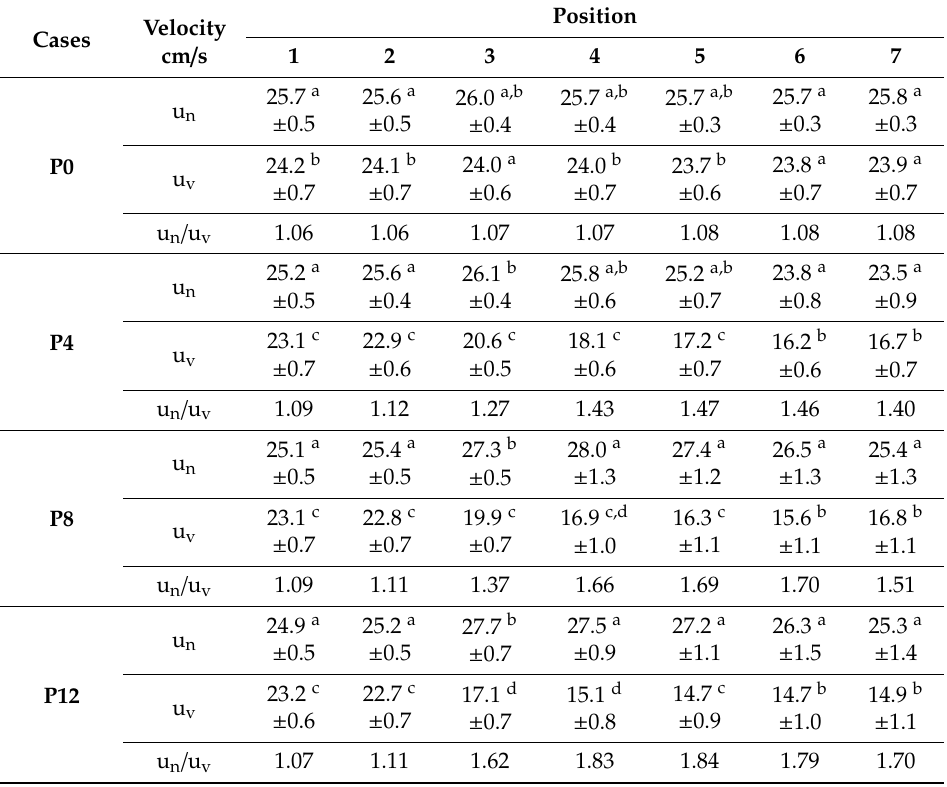
Table 2. The mean velocity ratio under di ff erent